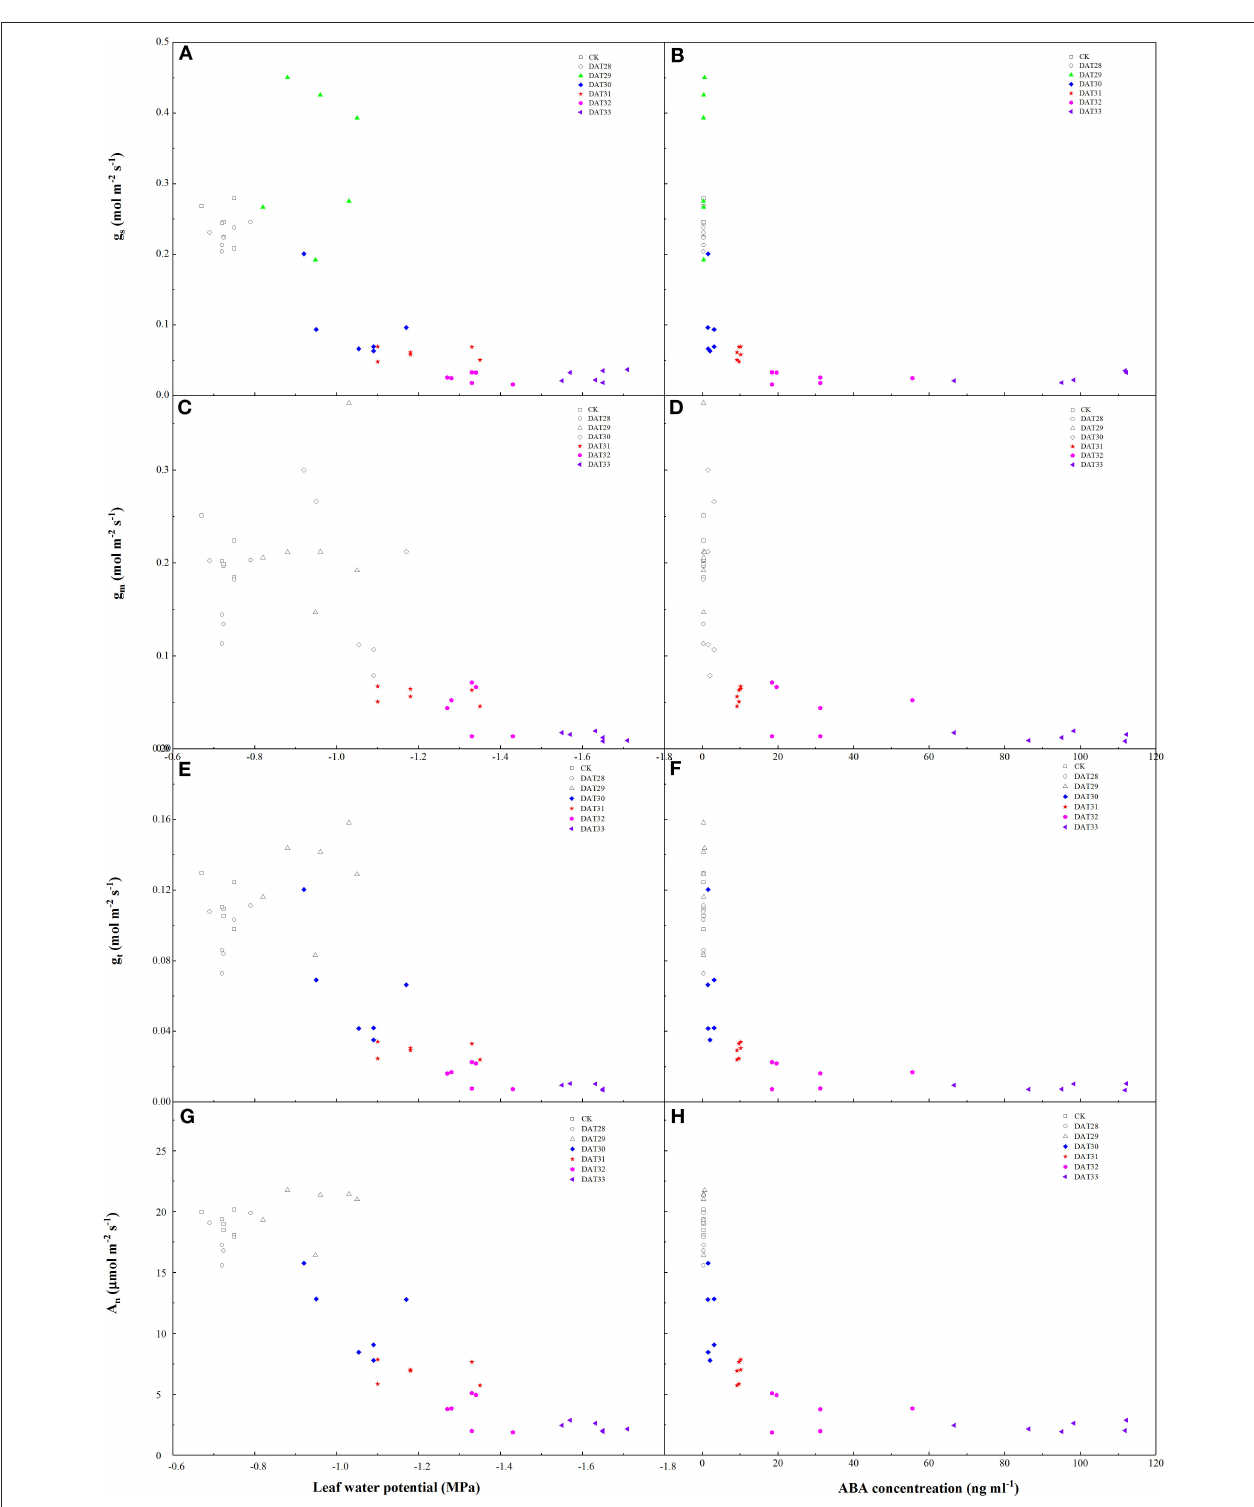
FIGURE 4 | Effects of leaf water potential, ABA concentration on stomatal conductance (g s ) (A,B) , mesophyll conductance (g m ) (C,D) , total conductance (g t ) (E,F), and net photosynthesis (A n ) (G,H) . Colorful labels indicated significant difference between the well-watered (CK) and drought treatments at P < 0.01 level.